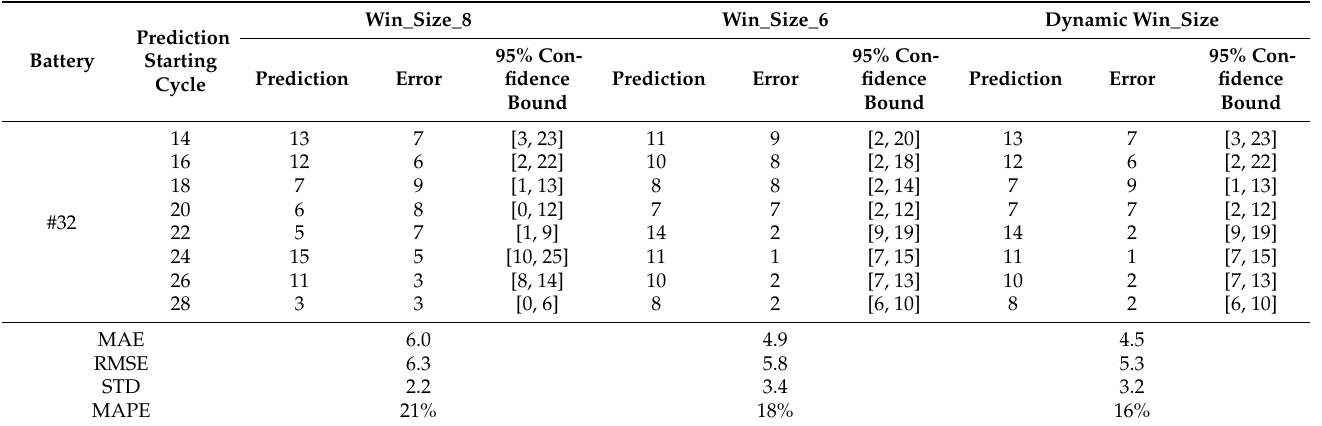
Table A2. Details of the RUL prediction results on No. 32 with different window sizes.